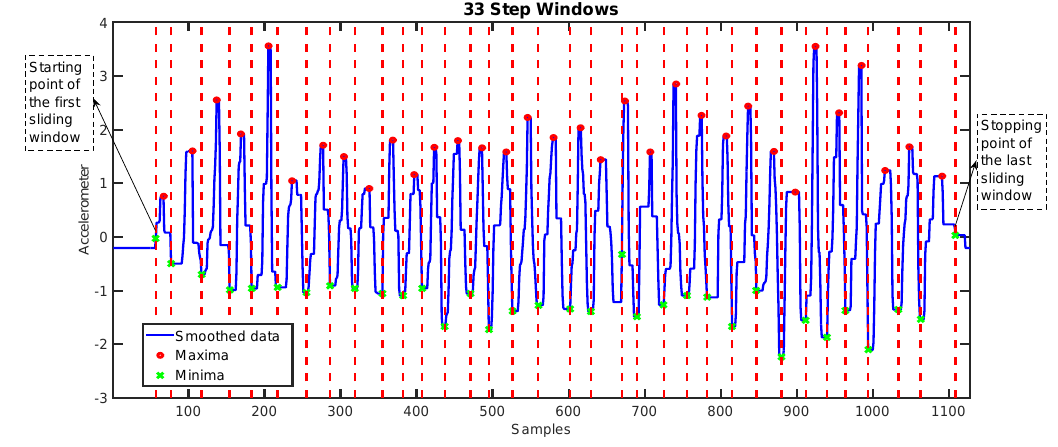
Figure 7. Step detection from smoothed data with maxima and